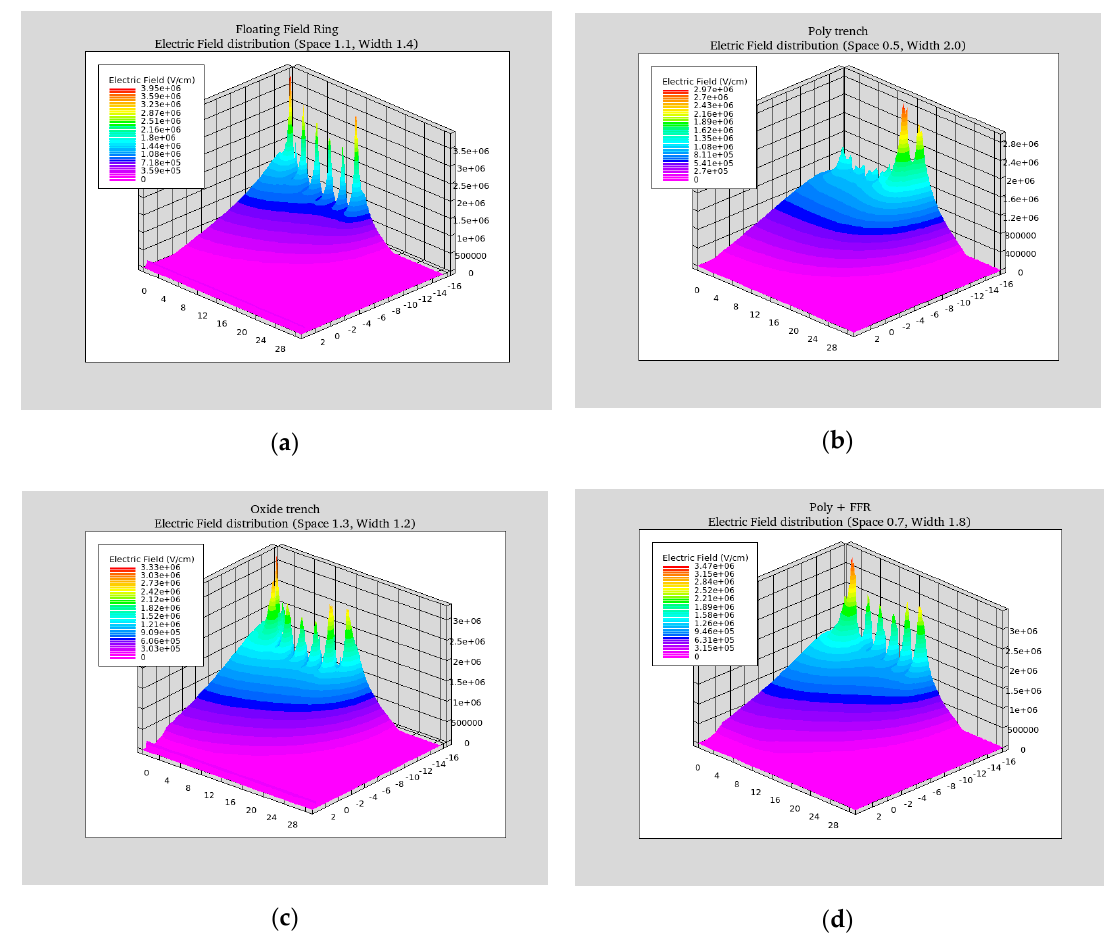
Figure 4. ( a ) Electric field distribution of the conventional FFR (E max = 3.95 MV/cm ) , ( b ) Electric field distribution of the trenched structure filled with polysilicon (E max = 2.97 MV/cm ) , ( c ) Electric field distribution of the trenched structure filled with oxide (E max = 3.33 MV/cm ) , and ( d ) Electric field distribution of a combination of the poly-trench and the conventional FFR (E max = 3.47 MV/cm )